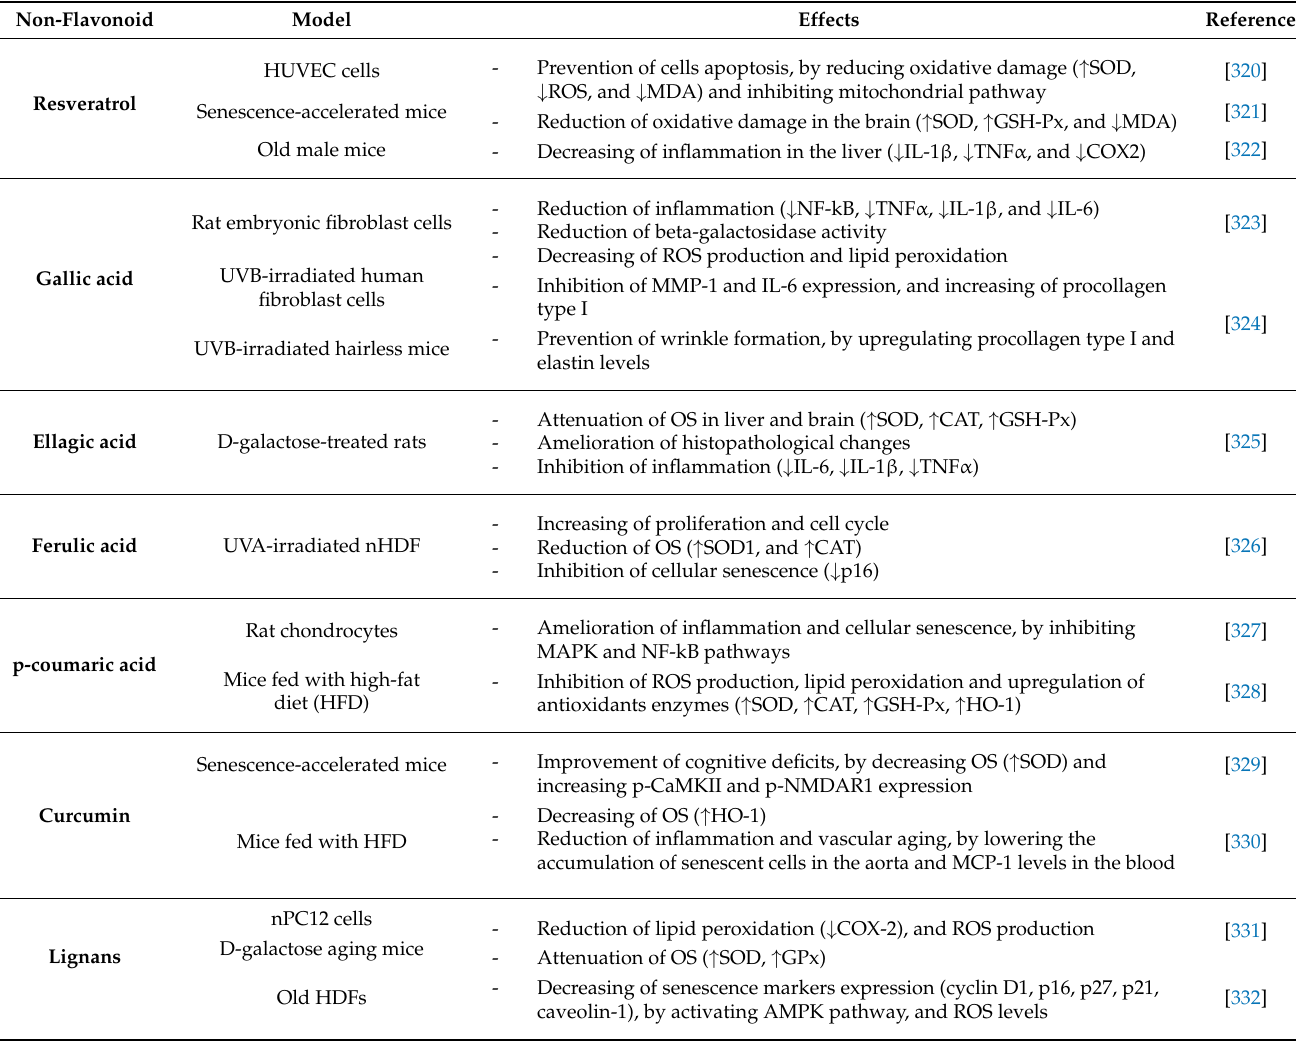
Table 4. Effects of non-flavonoids treatment in different experimental